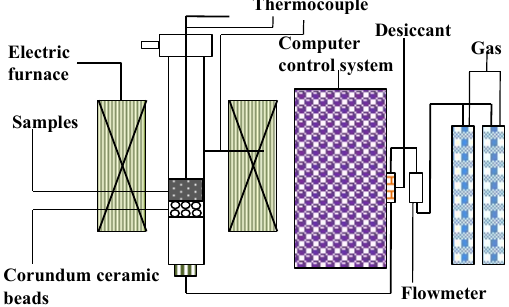
Figure 1. Schematic diagram of the reduction test device.